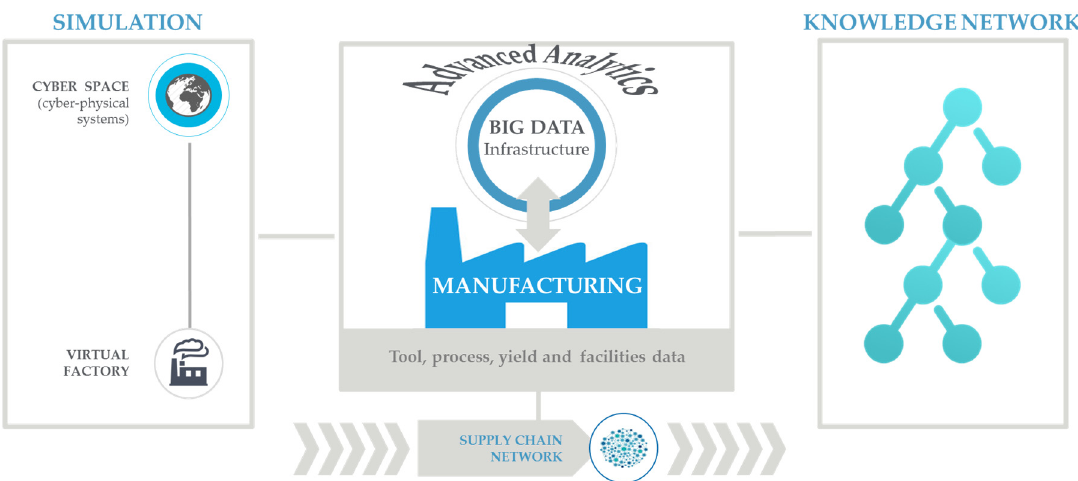
Figure 10. A smart manufacturing vision depiction for semiconductor manufacturing, with permission from [17]. Copyright Advanced Process Control Conference,